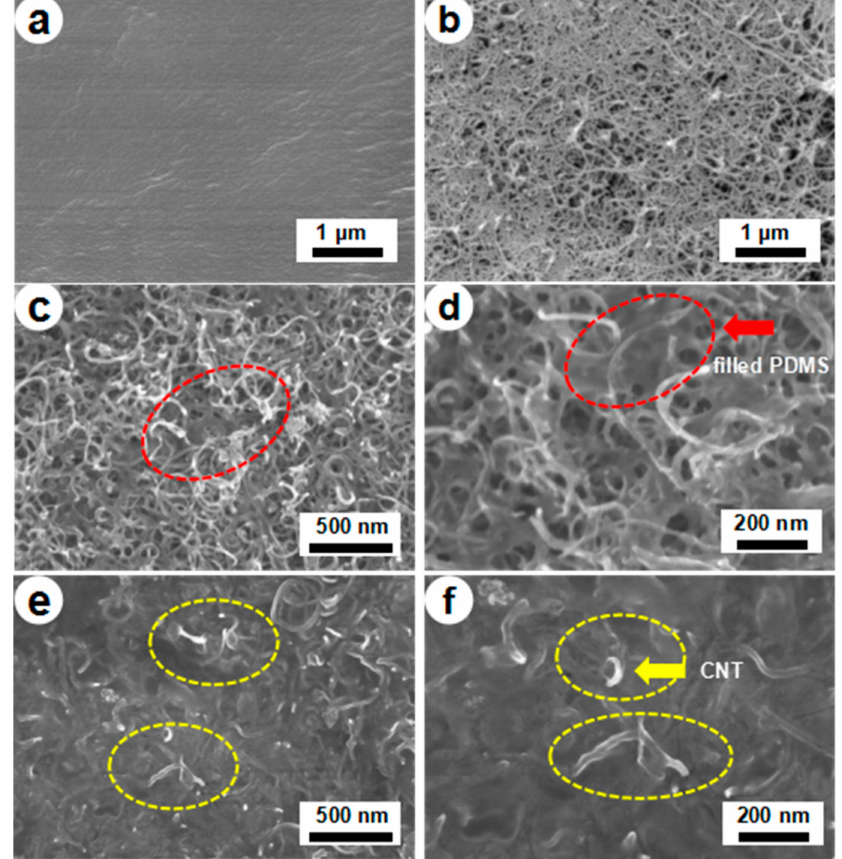
Figure 2. Field emission scanning electron microscope (FE-SEM) images of Pure PDMS ( a ) CNF/CNT ( b ) PDMS-1/CNF/CNT composite film ( c ) × 50,000 ( d ) × 100,000 and PDMS-30/CNF/CNT composite film ( e ) × 50,000 and ( f ) ×